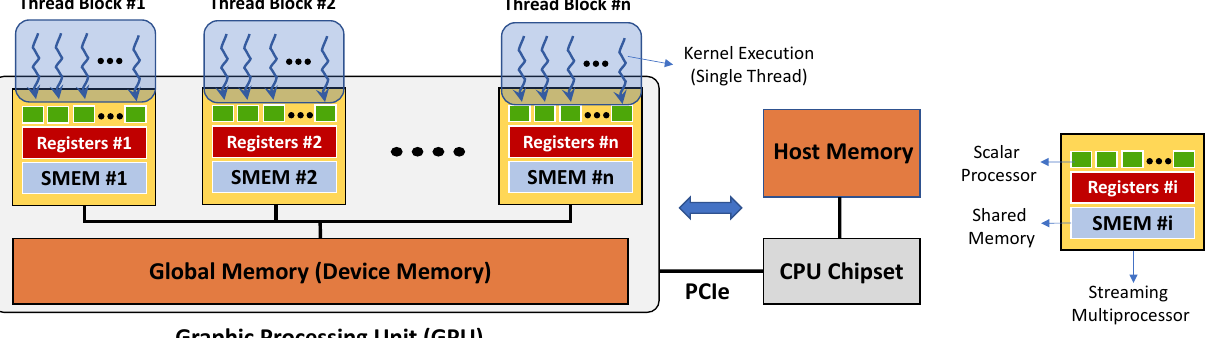
Figure 3. Schematic of GPU and CPU communication and memories. Left, memory interaction on a single execution grid created by a single kernel call, with N sketched (thread) blocks and multiple threads within the blocks on GPU. Right, CPU interface and